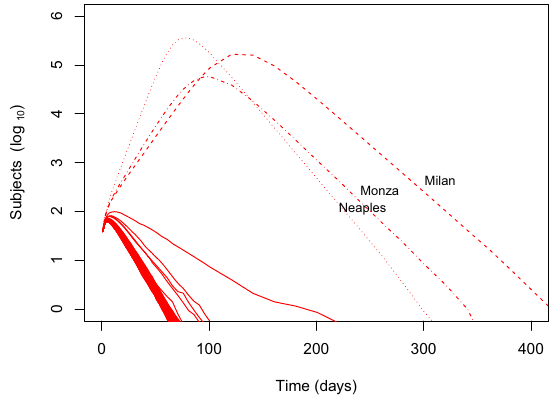
Fig. 5 Epidemic curve by district. Epidemic curve for individual nodes (districts) in the scenario with average velocity v ¼ 1 : 5 and fraction of app users j = 25%. The epidemic outbreak is entirely sustained by the three highest-density districts, whereas in the others the effective reproductive number is below